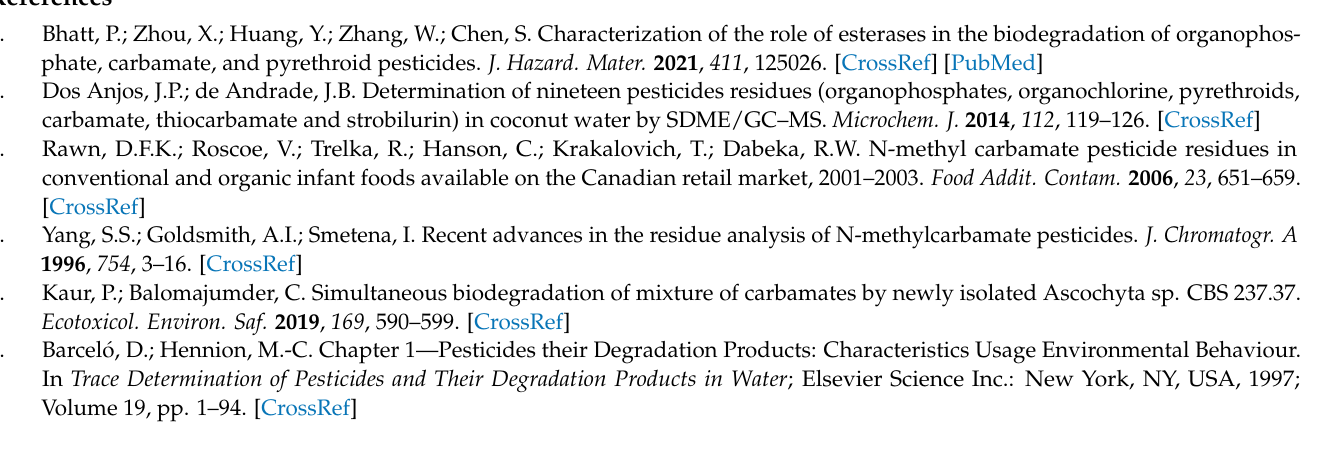
mates set; Table S1. Coefficients for quadratic least Squared regression model, Table S2. Coefficients for stepwise selection regression model, Table S3. Coefficients for Ridge and Lasso regularization techniques in regression